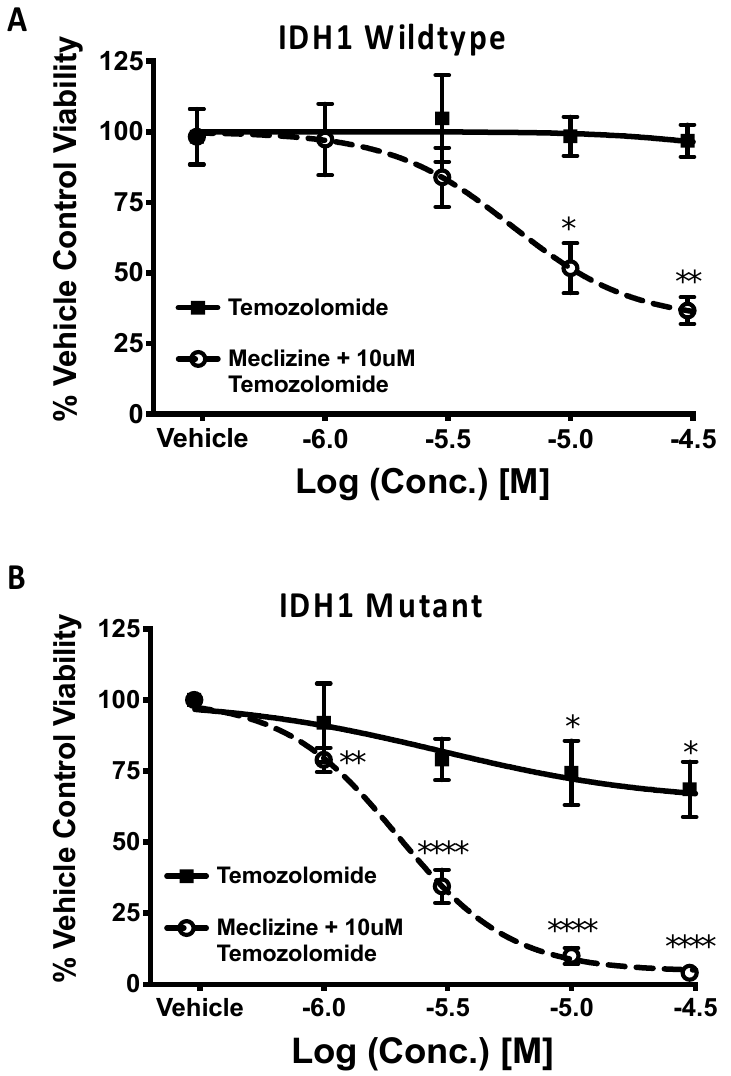
Figure 6. Comparison of cell viability reduction by temozolomide and by co-administration of meclizine and 10 µM temozolomide to the IDH1 wildtype ( A ), and in IDH1 R132H mutant ( B ) GBM patient-derived stem cells. The X-axis is the concentration of compounds tested. When meclizine was co-administered, the concentration of temozolomide was fixed at 10 µM. Experimental points are the average of 3 independent experiments; error bars are the standard error of the mean. The lines are the 4-parameter-model sigmoidal dose–response curves. *, **, **** p < 0.05, 0.01, 0.001, 0.0001, respectively. Best-fitting values for meclizine + temozolomide co-administration in wildtype ( A ) were: IC50 = 5.7 µM, Rmin = 33.27, R2 = 0.99, p = 7.5 × 10 –8 . n = 4 for vehicle, n = 3 for each concentration of meclizine + temozolomide. Best-fit values for temozolomide alone in wildtype ( A ) were: IC50 = 3.2 × 10 –5 , Rmin = 93.2, R2 = 0.71, p -value = 3.5 × 10 –2 . n = 4 for vehicle, and 3 for each concentration of temozolomide for a total of 12 concentrations of temozolomide. Best-fit values for meclizine co-administered in mutant ( B ) were: IC50 = 1.9 µM, Rmin = 4.1%, R2 = 0.99, p- value = 2.0 × 10 –6 . n = 10 for vehicle. n = 4 for each concentration of meclizine + temozolomide for a total of 16 measurements. Best-fit values for temozolomide in mutant ( B ) were: IC50 = 3.3 × 10 –6 , Rmin = 62.5%, R2 = 0.982, p –value = 6.1 × 10 –5 . n = 1 for vehicle. n = 6 for each concentration of temozolomide (24 measurements in total) .